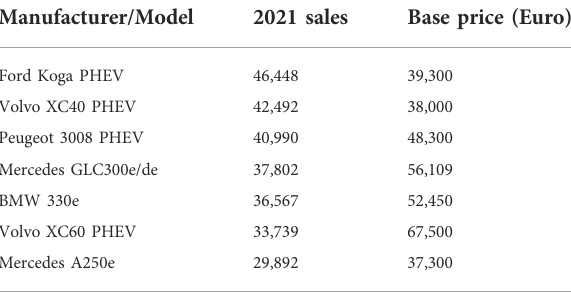
TABLE8RankorderingofPHEVmodelsineuropebasedon2021sales